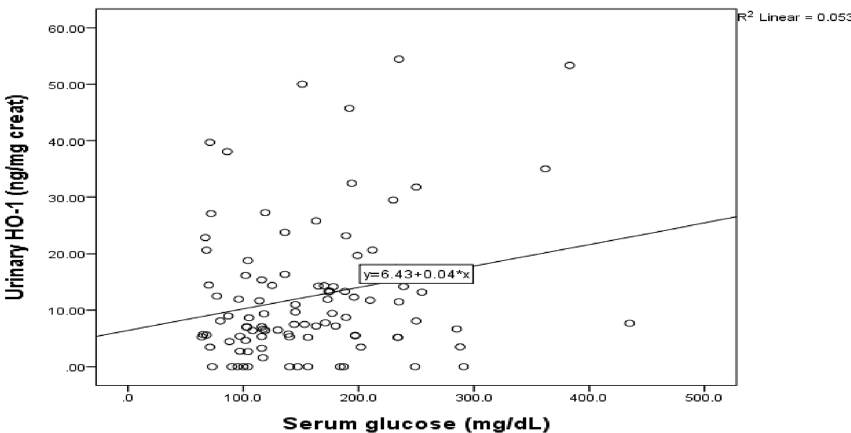
Figure 2. Correlation between level of urinary hemeoxygenase and serum glucose in diabetic patient group.